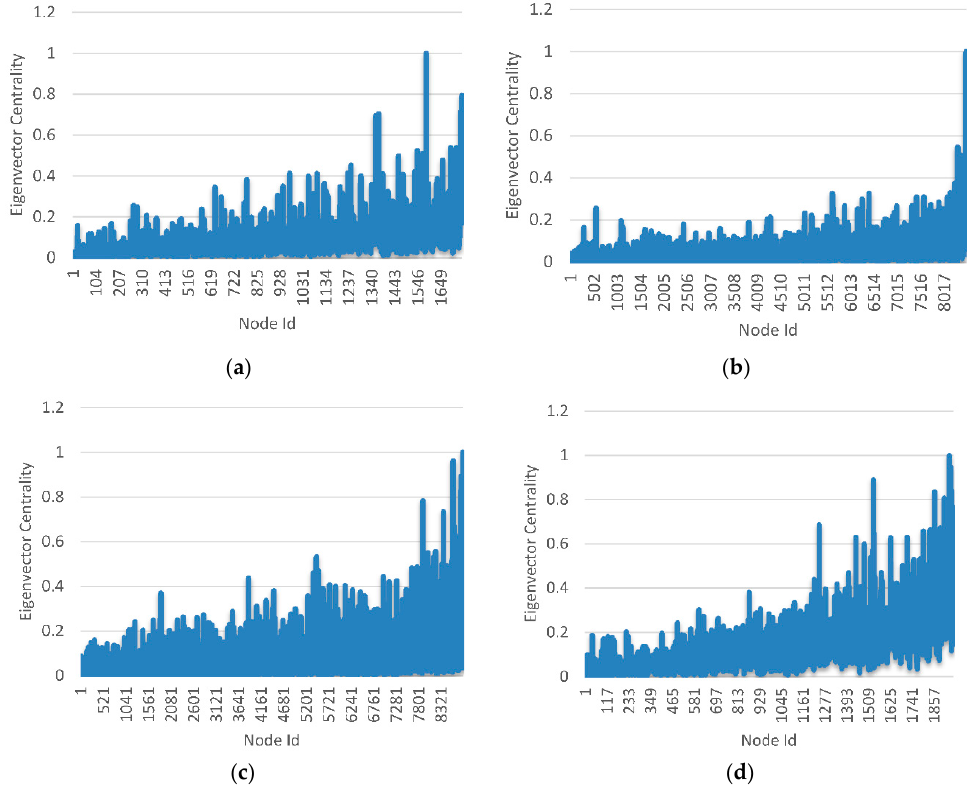
Figure 8. Eigenvector centrality distribution of sandstone network nodes: ( a ) 14.1%; ( b ) 16.9%; ( c ) 17.1%; ( d ) 24.6%.